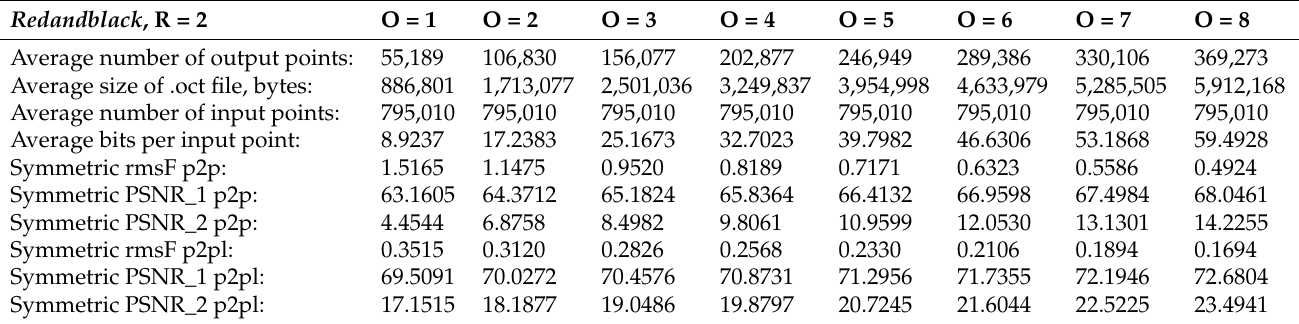
Table 14. Octree reduction using 3DTK toolkit, with voxel size “R” = 2 and different parameters for